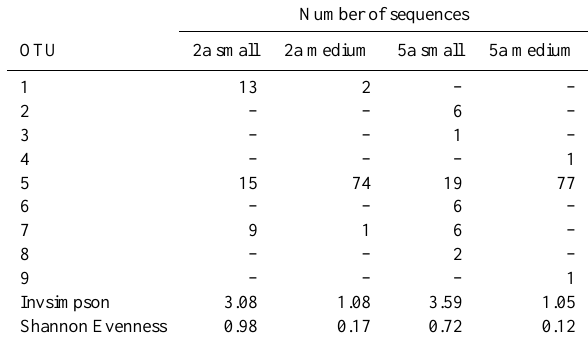
Table 2. Distribution of sequences among different operational tax- onomic units (OTU). In total sequences were consolidated in 4 groups: 2a small, 2a medium, 5a small and 5a medium. The subse- quent classification of sequences in different OTUs was done with mothur v. 1.26.0. on a 97% similarity level for each sample individ- ually. As indices for diversity and evenness the Invsimpson index and the Shannon Evenness index were applied,